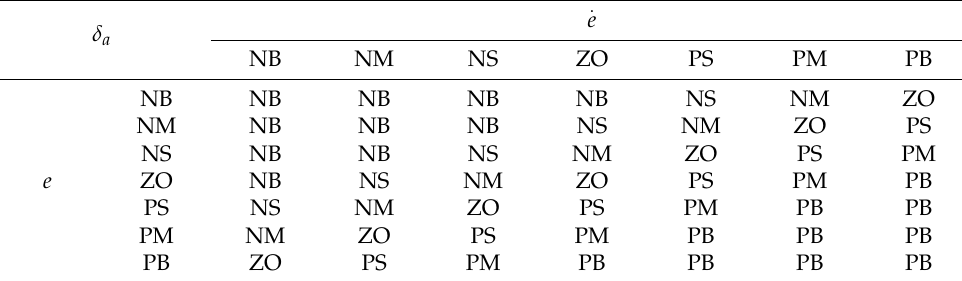
Table 1. FLC rules.